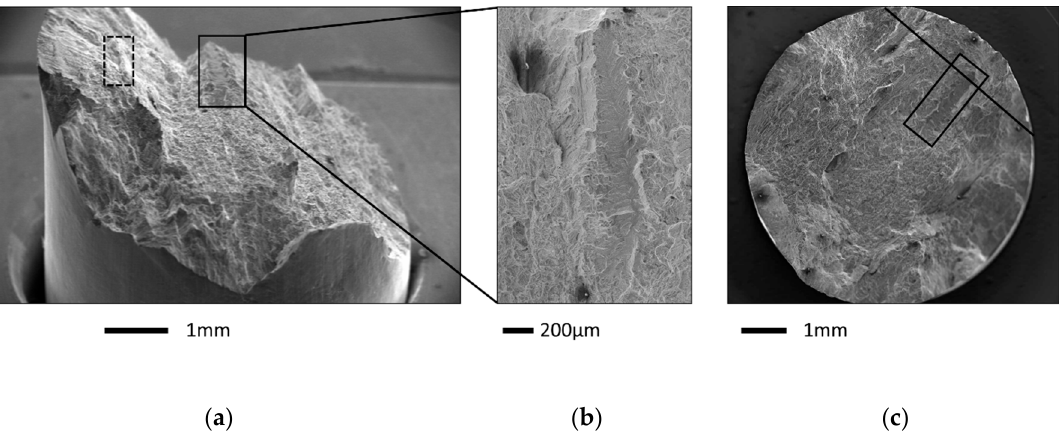
Figure 4. Fracture surface after dwell fatigue test along the radial direction r: ( a ) Uneven surface from a tilted angle; ( b ) Zoom of the elongated facet; ( c ) Top view of the fracture surface The region boxed in black locate the zone polished for microstructure analysis; the line illustrates the cut for transverse microstructure analysis on the complementary section.